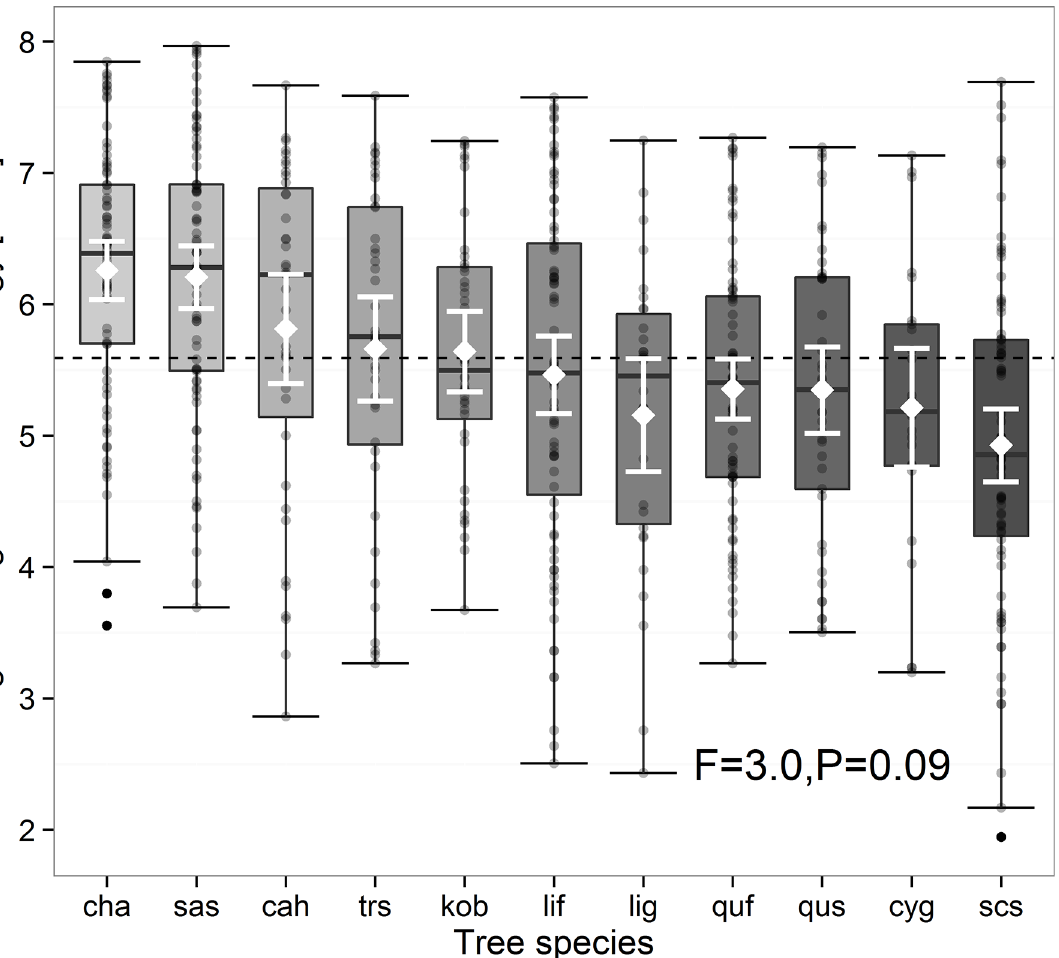
Fig 1. Throughfall kinetic energy (TKE, log-transformed) of the 11 species analyzed. Dotted line represents the total mean TKE. Inside the boxplots white rectangles represent mean and white bars standard deviation. For abbreviations of species names see Table